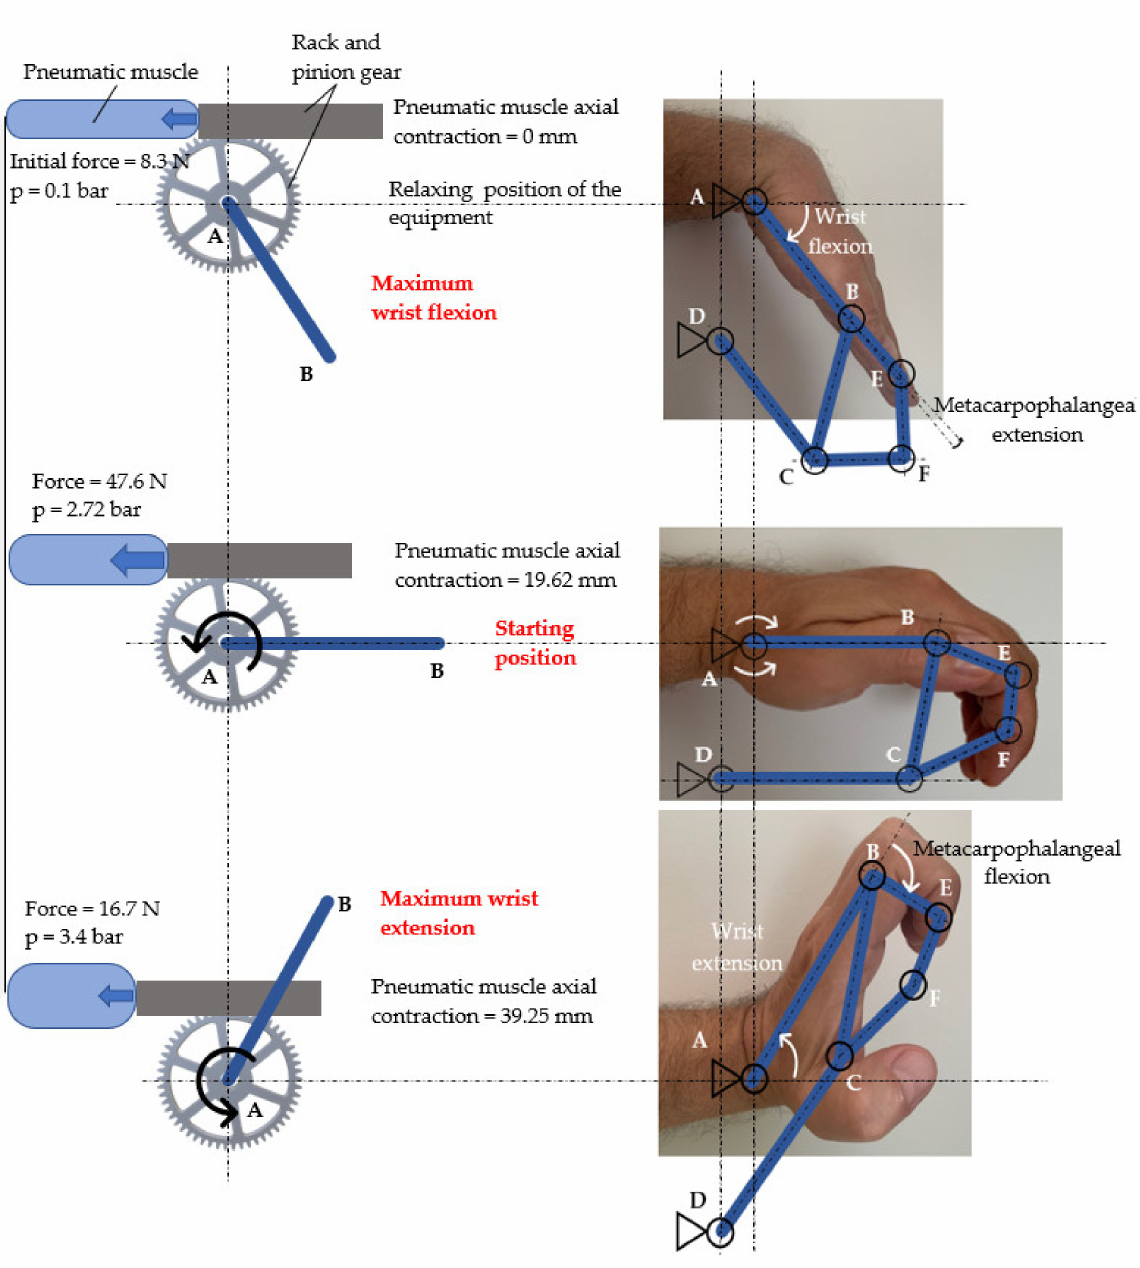
Figure 9. Various positions of lever AB in dependance on the charging of the pneumatic muscle. Figure 10 shows the rehabilitation equipment in start position. Compressed air is fed to the muscle through an MPPES-3-1/4-6-010 proportional pressure regulator controlled by an MPZ-1-24DC-SGH-6-SW reference module